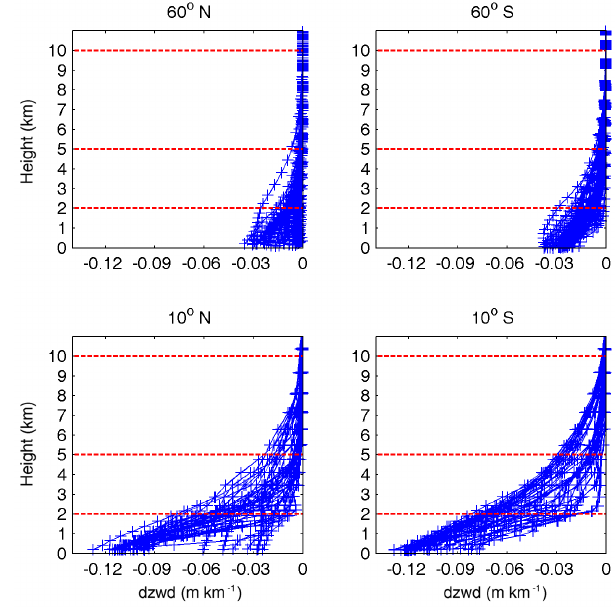
Figure 3. ZWD gradients profiles at grid points in different latitude bands (12:00UTC, 1 January